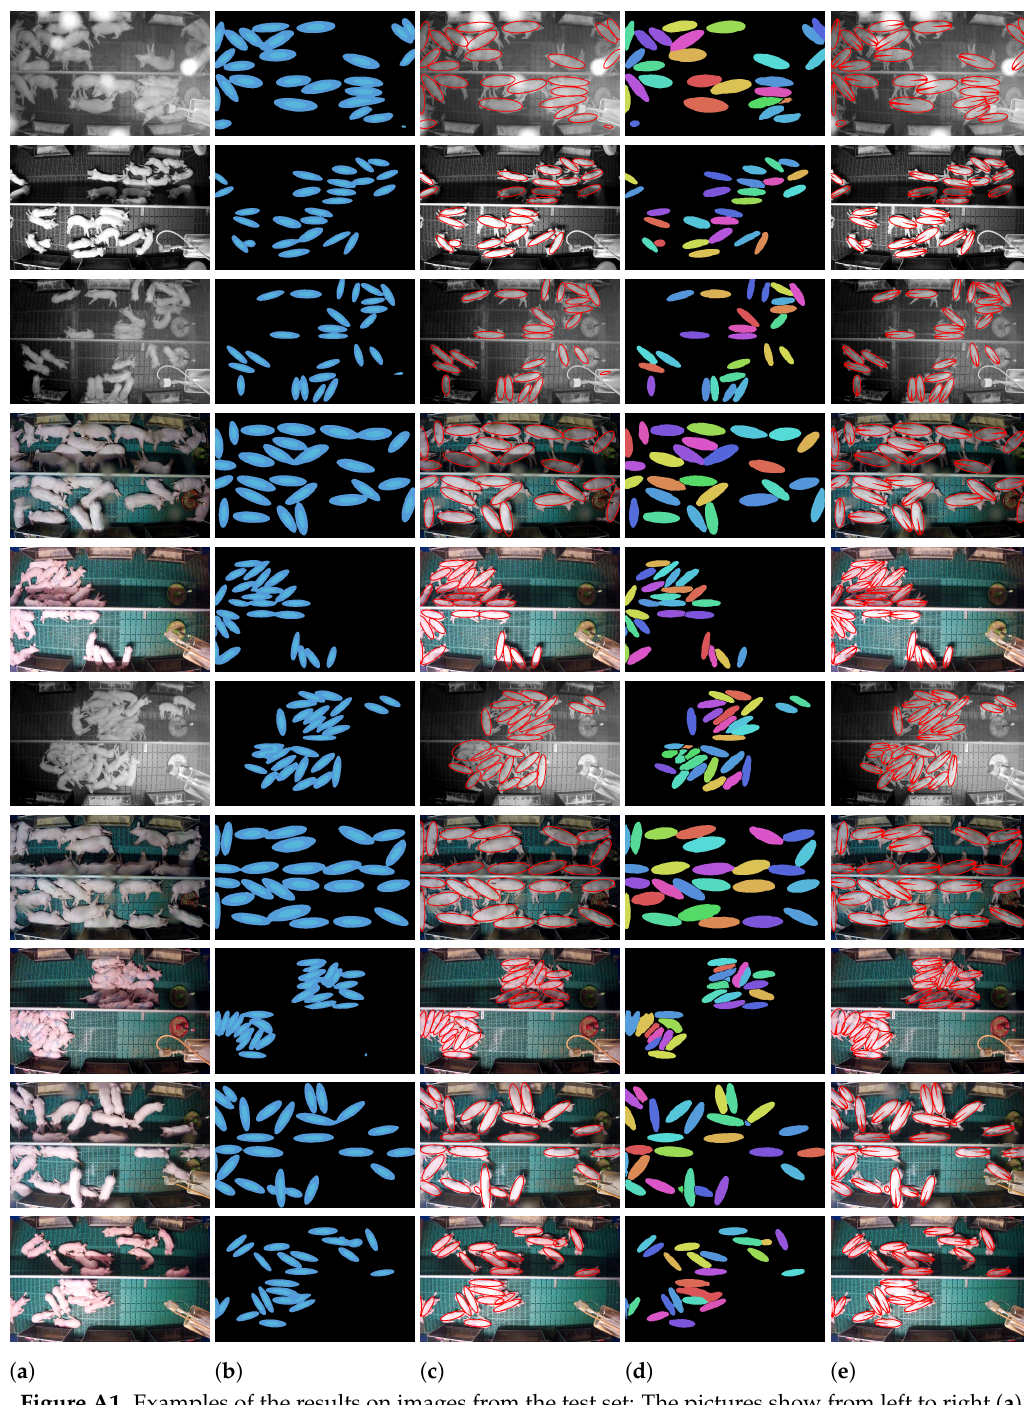
Figure A1. Examples of the results on images from the test set: The pictures show from left to right ( a ) the original image; ( b ) the prediction of the categorical segmentation; ( c ) the ellipses extracted from the categorical segmentation; ( d ) the prediction of the combined segmentation; and ( e ) the ellipses extracted from the combined segmentation (including orientation recognition). The filled part of the ellipses shows the identified orientation of the